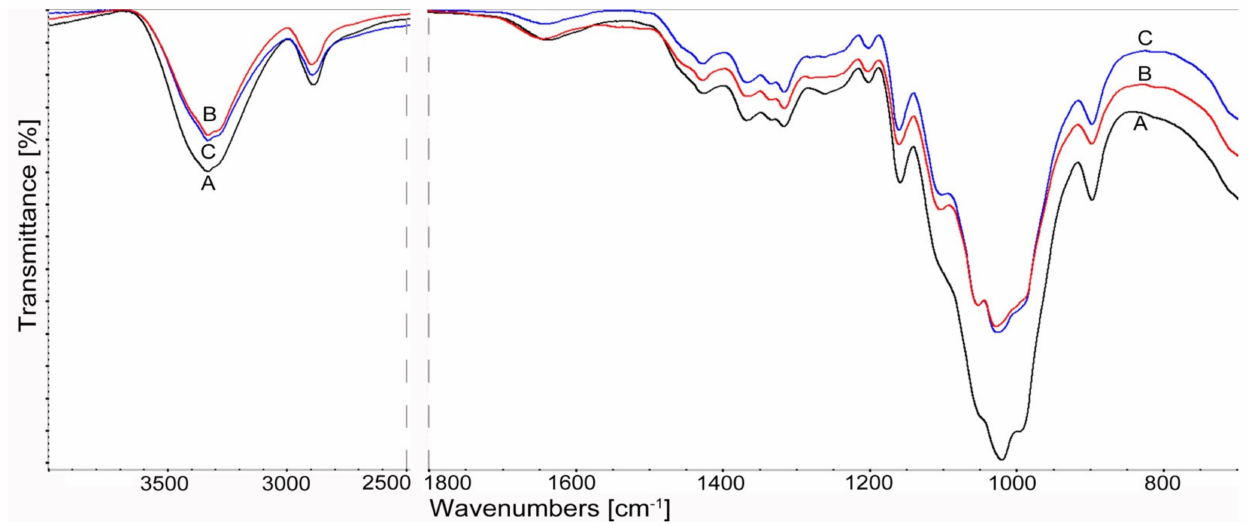
Figure 5. FTIR spectra of cellulose Cel_B after enzymatic reaction in the range 4000–500 cm − 1 : A Cel_B, B Cel_B-Tr, C